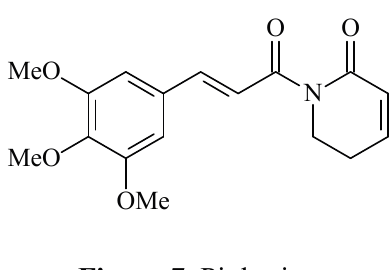
Figure 7. Piplartine.